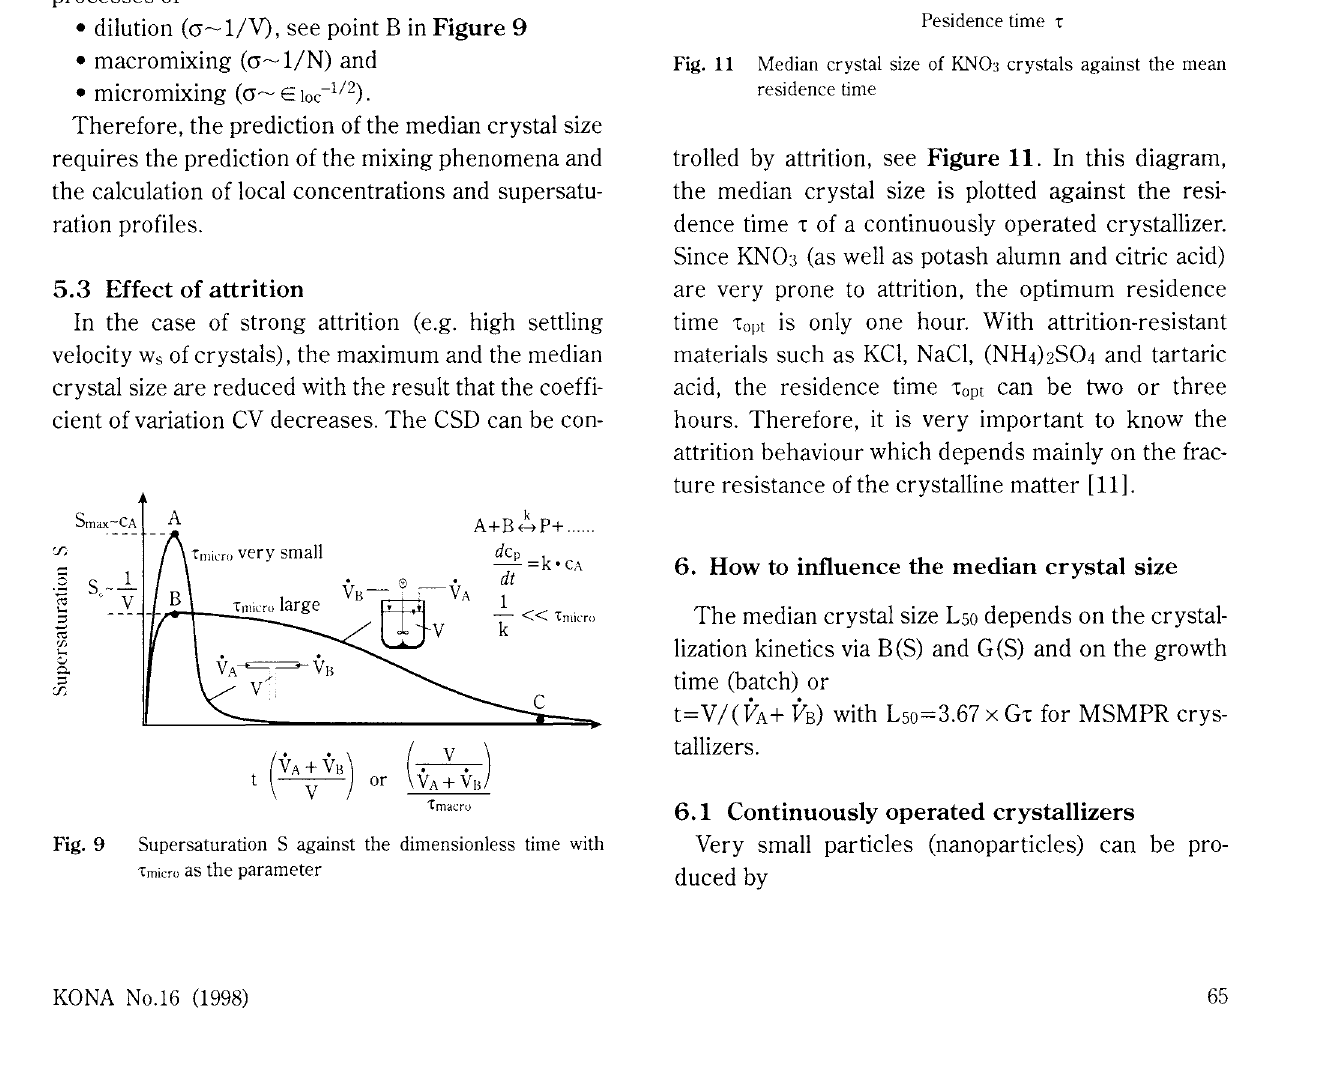
Fig. 11 Median crystal size of KN03 crystals against the mean residence time